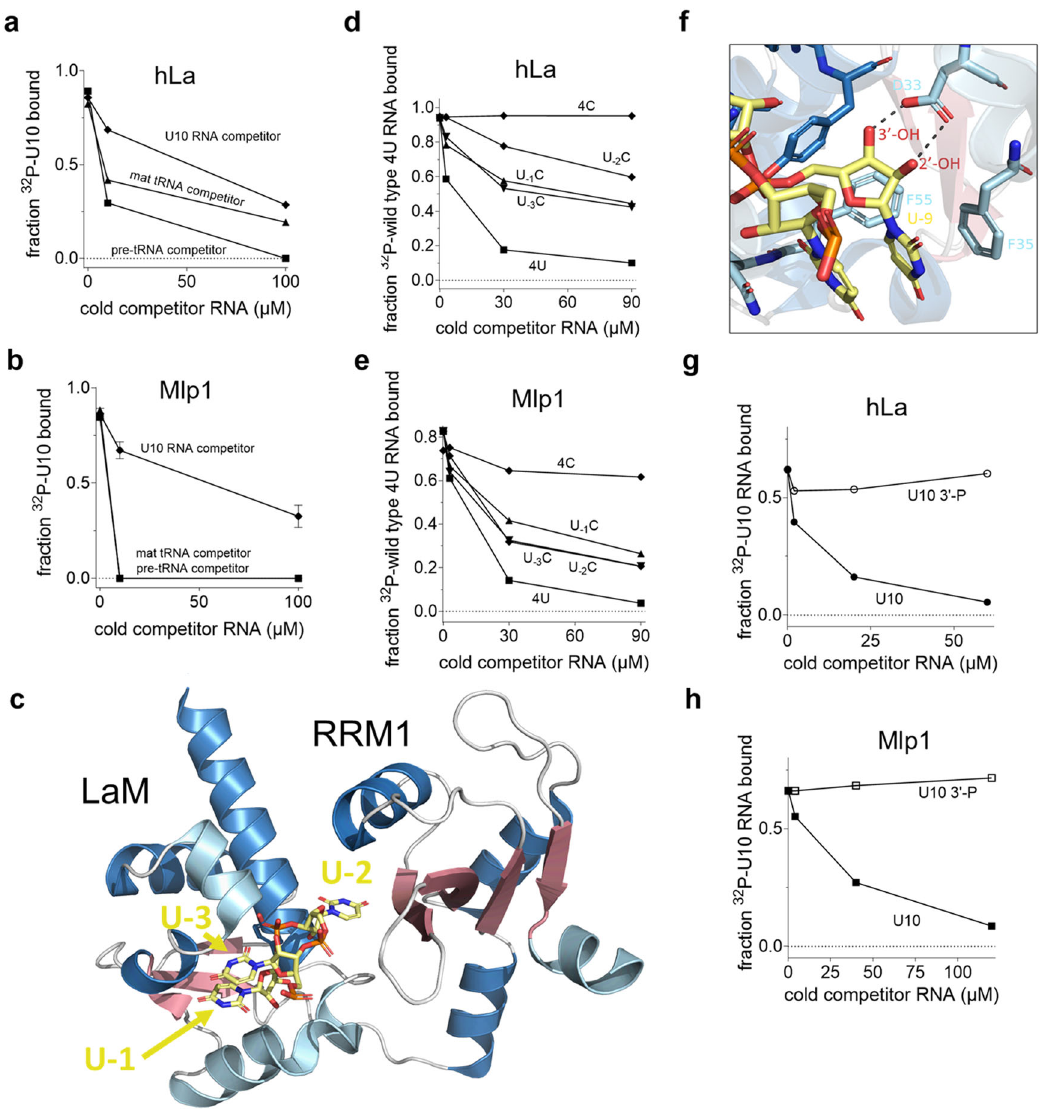
Fig. 3 | Mlp1 does not discriminate 3 ’ -uridylates as stringently as hLa. a , b Binding curves from competition EMSA between 32 P-labeled uridylate RNA (U10) and unlabeled competitor U10 RNA (control), 5 ’ -leader and 3 ’ -trailer-con- taining T.thermophila pre-tRNALeu AAG andmaturetRNALeu AAG forhLa( a )andMlp1 ( b ). Error bars represent the mean +/ − standard deviation (Mlp1 U10: n =4, tRNA: n =2,hLaU10: n =2,tRNA: n =1independentexperiments).Nativegelsareshownin Supplementary Fig. S5a. c Three-dimensional representation of the hLa protein in complex with uridylate RNA with the last three terminal nucleotides shown (UUU- 3 ’ OH)(PDB:2VOD).ThepenultimateuridylateU − 2 ispositionedinbetweentheLaM and RRM1, while the 3 ’ -terminal uridylate U − 1 is positioned more towards the out- side in stacking formation with U − 3 . RNA is shown in yellow; β -sheets are shown in red and α -helices shown in blue (dark blue: typical α -helices found in the winged- helix fold and classic RRM, light blue: inserted α -helices speci fi cally found in